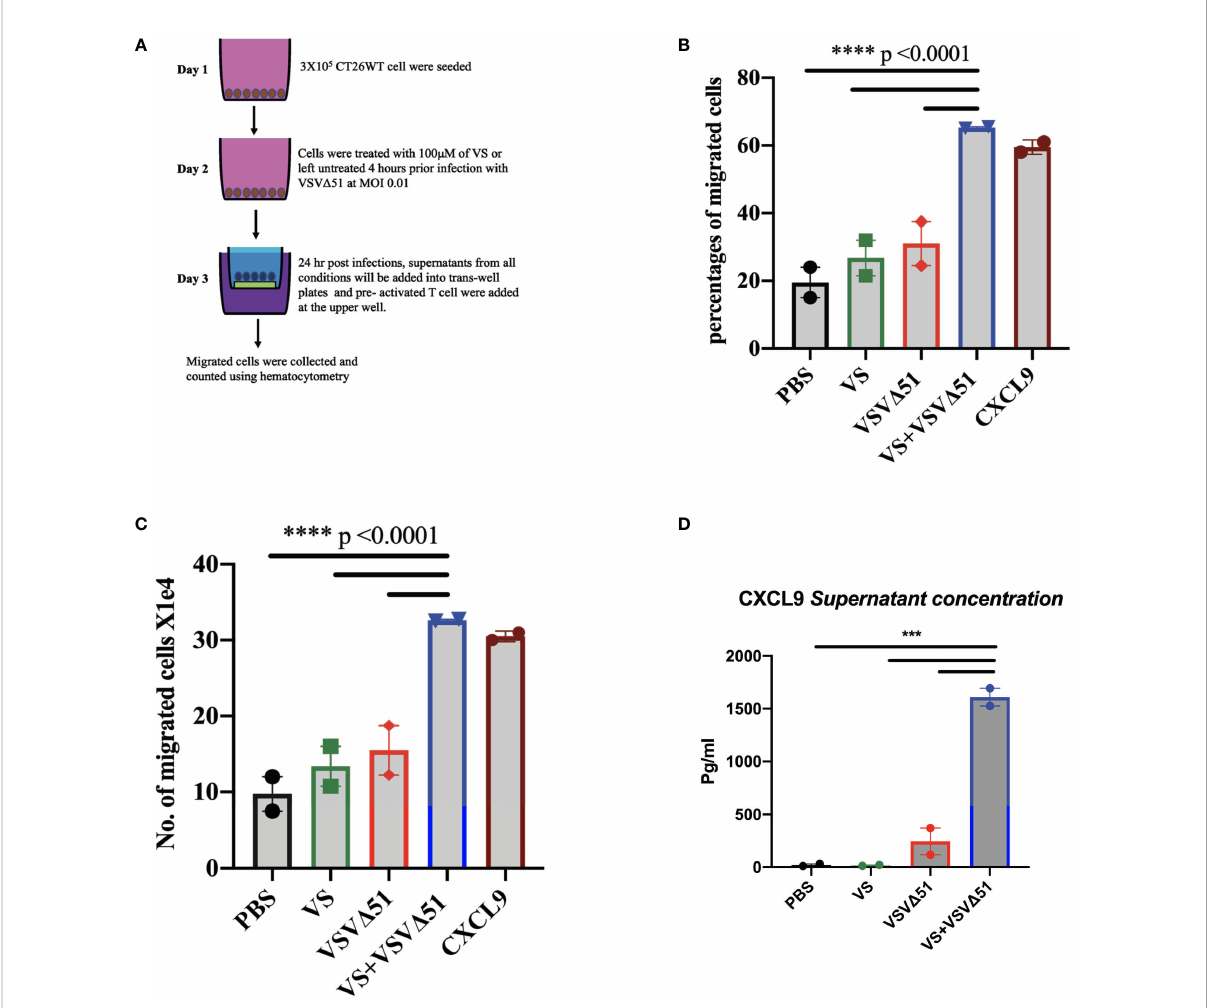
FIGURE 4 Vanadyl sulfate in combination with VSV D 51 increases the production of T-cell chemoattractant and T-cell migration in vitro . (A) Tissue culture supernatants were collected after treating CT26WT cells with vanadyl sulfate at a concentration of 100 m M for 4 hours prior infection with VSV D 51 at MOI 0.01 or with PBS, vanadyl sulfate alone or VSV D 51 alone for 24 hour and subsequently used for the assessment of chemokines or for performing chemotaxis assays (compared to CXCL9 control). Chemotaxis of T cells was assessed using a Trans-well system. (B) Migration percentage was calculated as (total number T cells in bottom chamber/total number T cell input) x 100. (C) The Number of migrated cells X10 4 with the mean of the duplicate for each condition. Mean ± SEM; ****P<0.0001, Two-way ANOVA. Representative data of the average of 2 independent experiments, n = 2 per condition. (D) The supernatant concentration of CXCL-9, graph shows the pg/ml. Mean ± SEM; n = 2 per condition, *** P = 0.001, Two-way